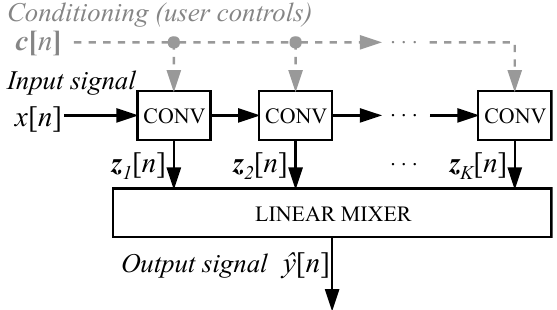
Figure 1. Proposed WaveNet-style neural network